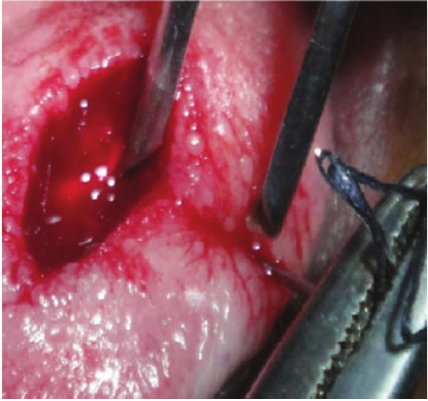
Figure 4: Sutures being placed.